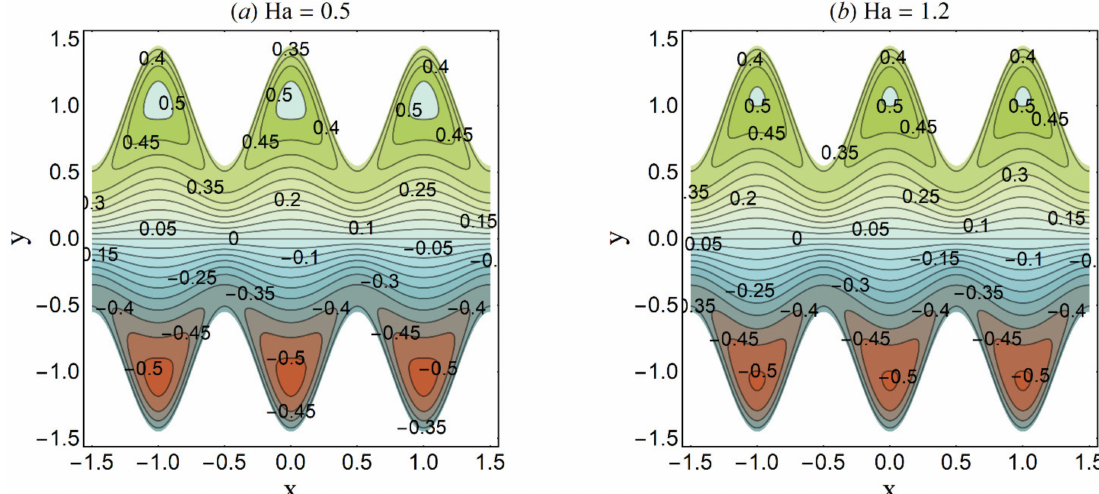
Figure 26. Streamlines for variation in Ha when n = 0.2 We = 0.05, α = 0.45, ε = 4, β = 0.1, U HS = 2, K = 2, Q = 0.4. ( a ) Ha = 0.5; ( b ) Ha =